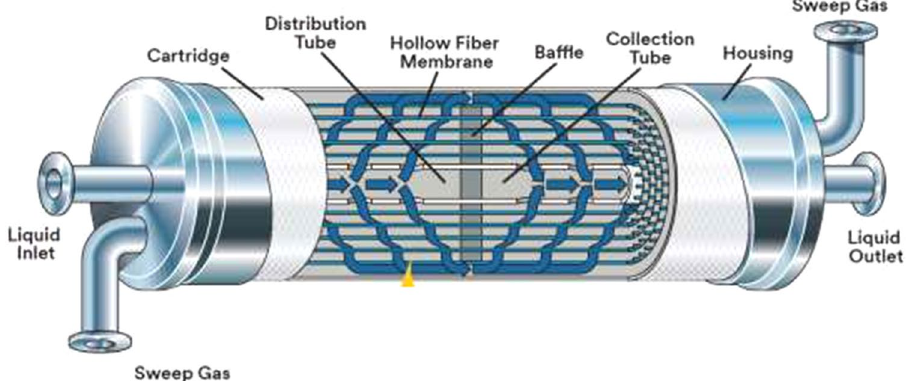
Fig. 6 SGMD model